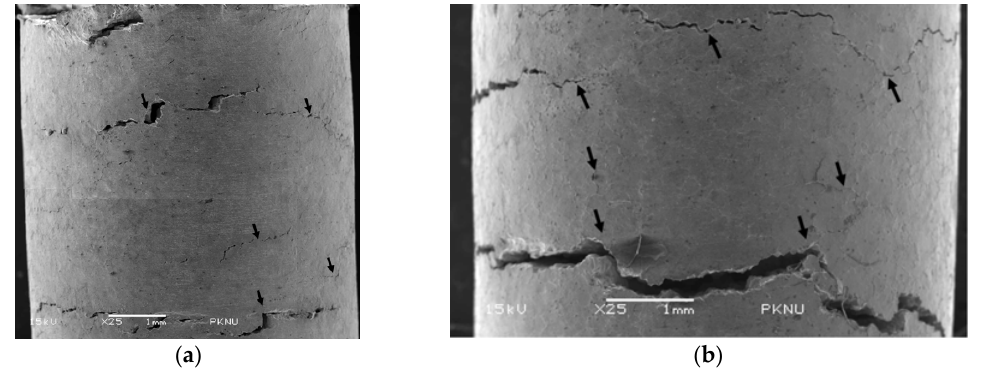
Figure 12. General view of LCF cracking of Alloy 617 fatigued specimens at 950 °C conditions were within the gage section: ( a ) for the 0.9% total strain range; and ( b ) for the 1.5% total strain range.